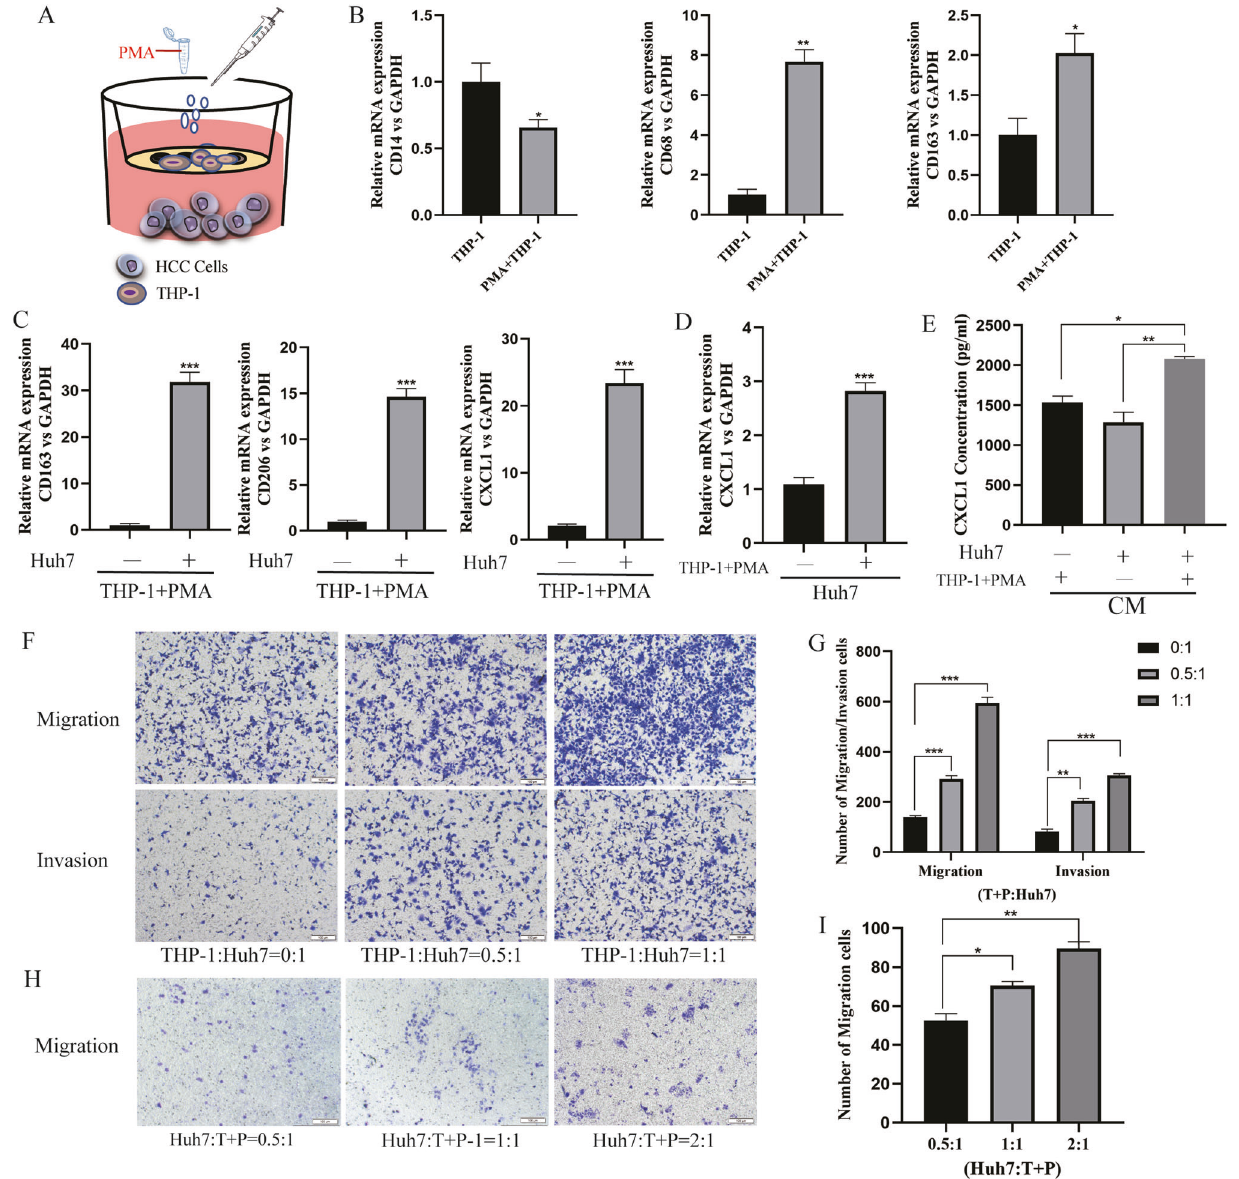
Fig. 3 Coculture of PMA-primed THP-1 cells with Huh7 cells promoted M2 polarization, macrophage CXCL1 secretion and HCC cell migration and invasions. A Schematic representation of the in vitro model for the coculture of PMA-primed THP-1 cells with Huh7 cells. B CD14, CD68, and CD163 production detected in PMA-primed THP-1 cells by qRT-PCR. Data are expressed as the mean ± SEM. * P < 0.05, ** P < 0.01 ( n = 3/group). C , D The relative mRNA expression of CD163, CD206, and CXCL1 in macrophages in the coculture system. Data